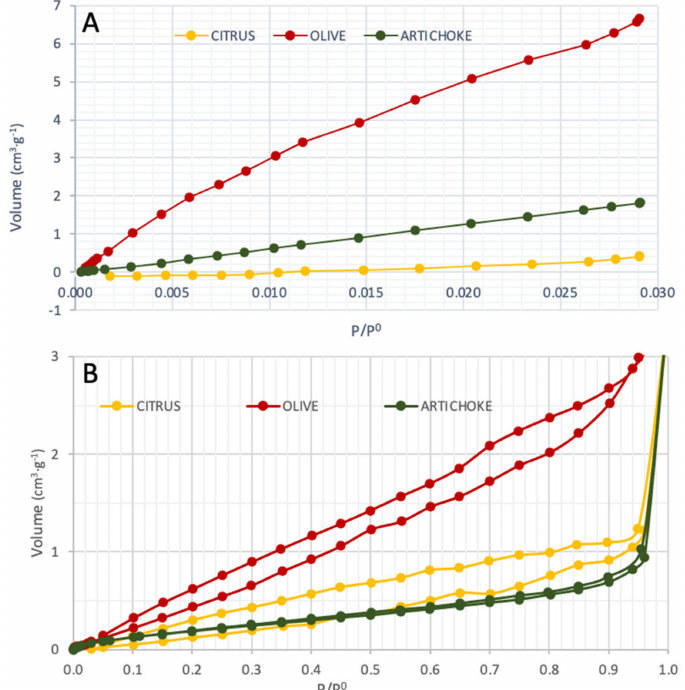
Figure 5. CO 2 ( A ) and N 2 ( B ) sorption isotherms of the artichoke agrowaste, olive mill residue and citrus waste.